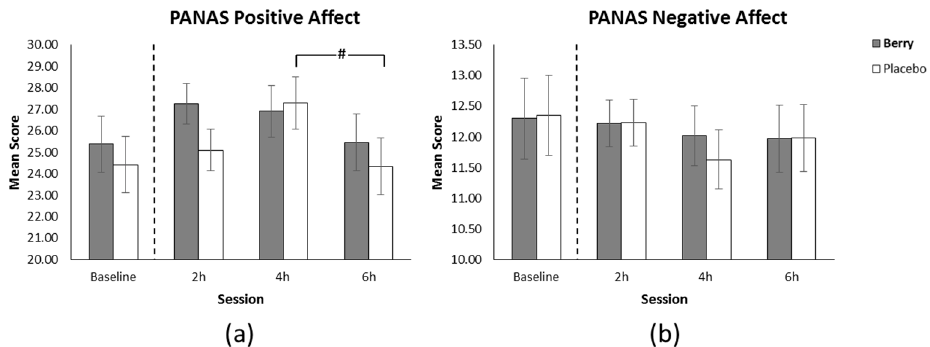
Figure 7. ( a ) Positive affect scores (±SE of the mean) as a function of intervention and session, showing a significant reduction at 6 h in comparison to 4 h for the placebo intervention. ( b ) Positive affect scores (±SE of the mean) as a function of intervention and session showing no difference between interventions at any time points.